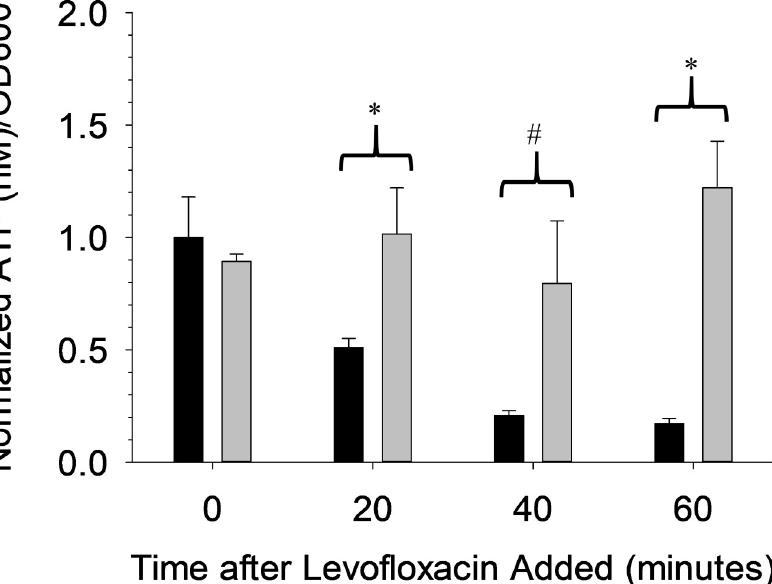
Fig 4. Normalized ATP/OD600 levels showing susceptibility of E . coli to a bactericidal antibiotic with only a 30 minute pre-incubation. The E . coli bacteria were preincubated for only 30 minutes with the antibiotic kanamycin (50 mg/L, black bars) which permits selective growth, before adding the antibiotic to which the bacteria are susceptible, levofloxacin (gray bars). Levofloxacin (5 mg/L) along with the antibiotic that permits selective growth, were compared against a control containing only the antibiotic that permits selective growth. n = 3; error = standard deviation; � p < 0.05; # p < 0.10.